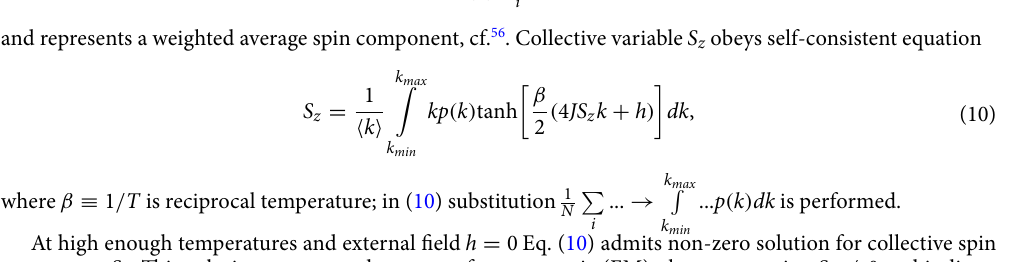
Figure 2. Dependence of ( a ) ζ , 1000 , and ( b ) ζ 21 (dash line) and N = are plotted in logarithmic